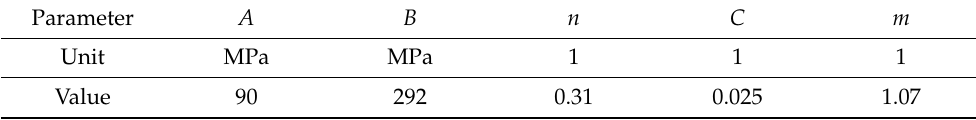
. ε 0 = 1 s − 1 , T 0 = 298 K, and T m = 1356 K).